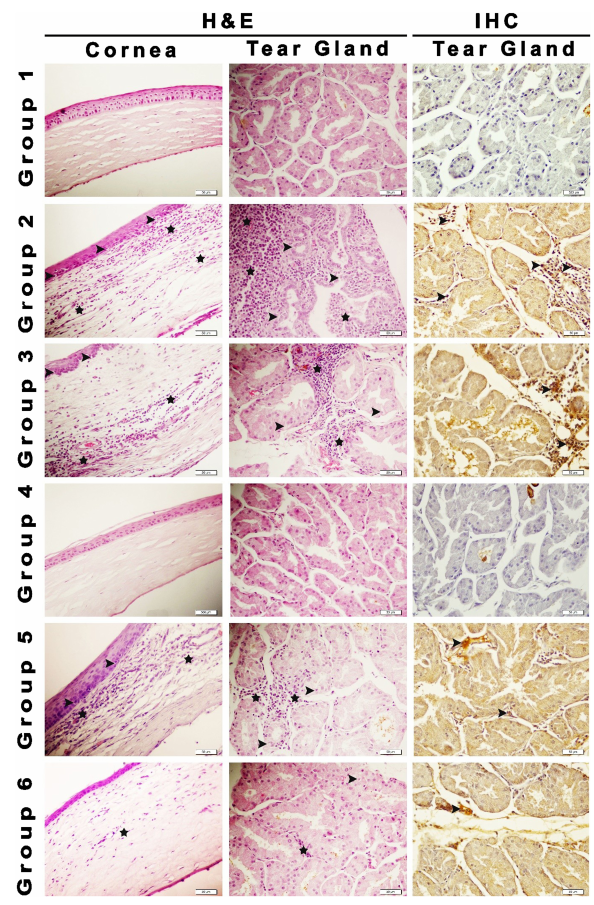
Figure 1. Cornea and lacrimal gland tissues, degeneration of corneal epithelium (arrowheads), inflammation of stroma (stars), degeneration of glandular epithelium (arrowheads), inflammation of interstitial spaces (asterisks), H&E, cytoplasmic TGF- β 1 expressions in inflammatory cells around vessels and interstitial spaces (arrowheads), IHC-P (Immunohistochemistry- Parafin Protocol), Bar: 50 μ m. H&E, hematoxylin and eosin; TGF- β 1, transforming growth factor- β